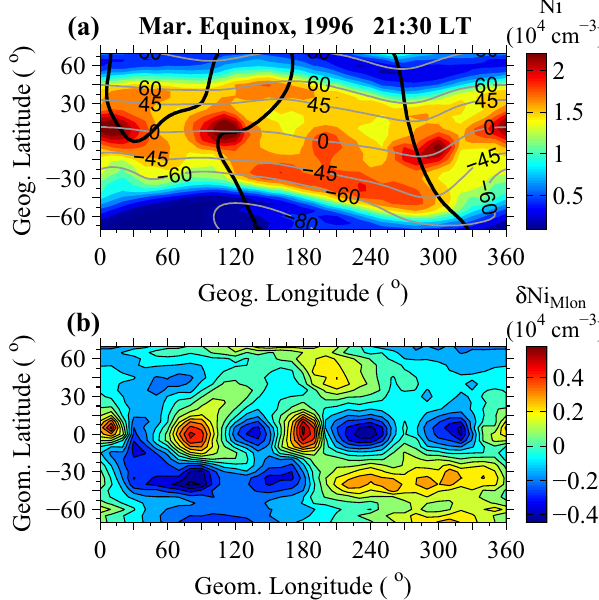
Fig. 3. (a) and (b) are same as Figures 1a and 1c, respectively, but for DMSP F12 nightside measurements around the March Equinox of